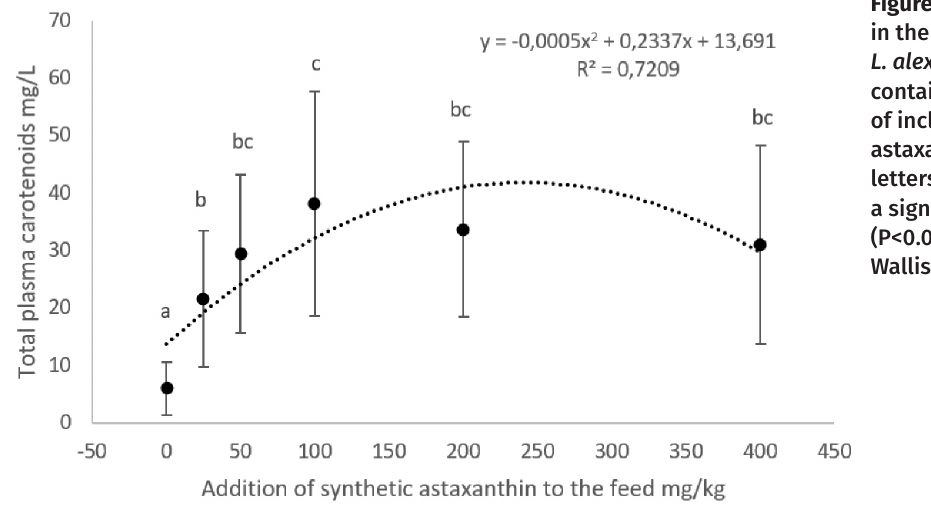
Figure 1. Total carotenoids in the blood plasma of L. alexandri fed a diet containing different levels of inclusion of synthetic astaxanthin. Different letters above the data show a significant difference (P<0.05) by the Kruskal - Wallis nonparametric